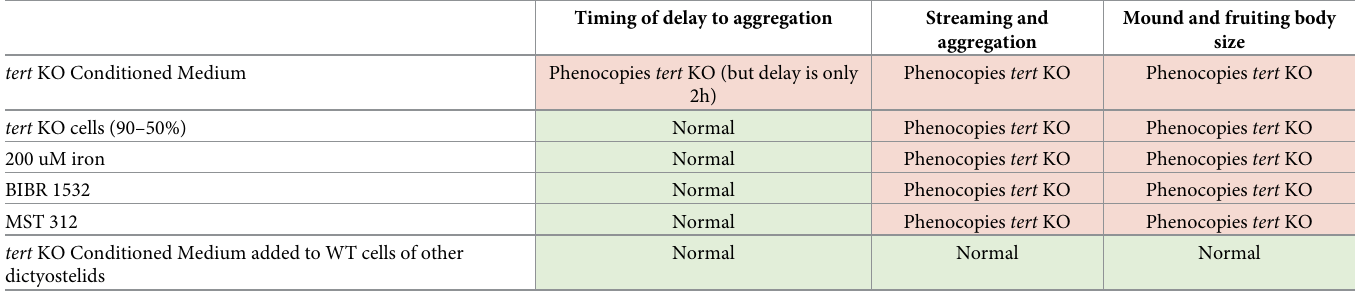
Table 3. Attempts to phenocopy the tert KO phenotype in wild-type Dictyostelium cells.